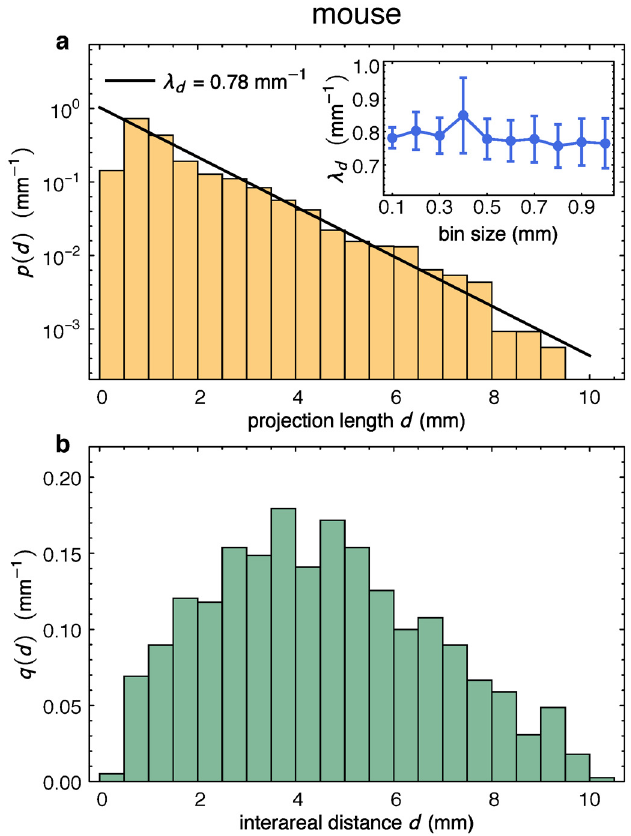
Fig 2. EDR parameters in mouse cortex. (a) Probability density function p ( d ) of direct neuron counts (about 2 million labeled neurons) versus distance from the injection site, generated using 13 retrograde tracer as a function of bin injections, see Materials and Methods. Inset shows the small variability of the fits for λ mus exp ¼ 0 : 78 mm − 1 , with a 95% con fi dence size. The decay rate, λ mus , is determined by an exponential fi t as λ mus exp exp interval of (0.72, 0.83) mm − 1 (see inset). (b) Interareal distance distribution q ( d ) in the mouse on the fl attened cortex, see Materials and Methods. First, the distance matrix D mus was generated from fl attened